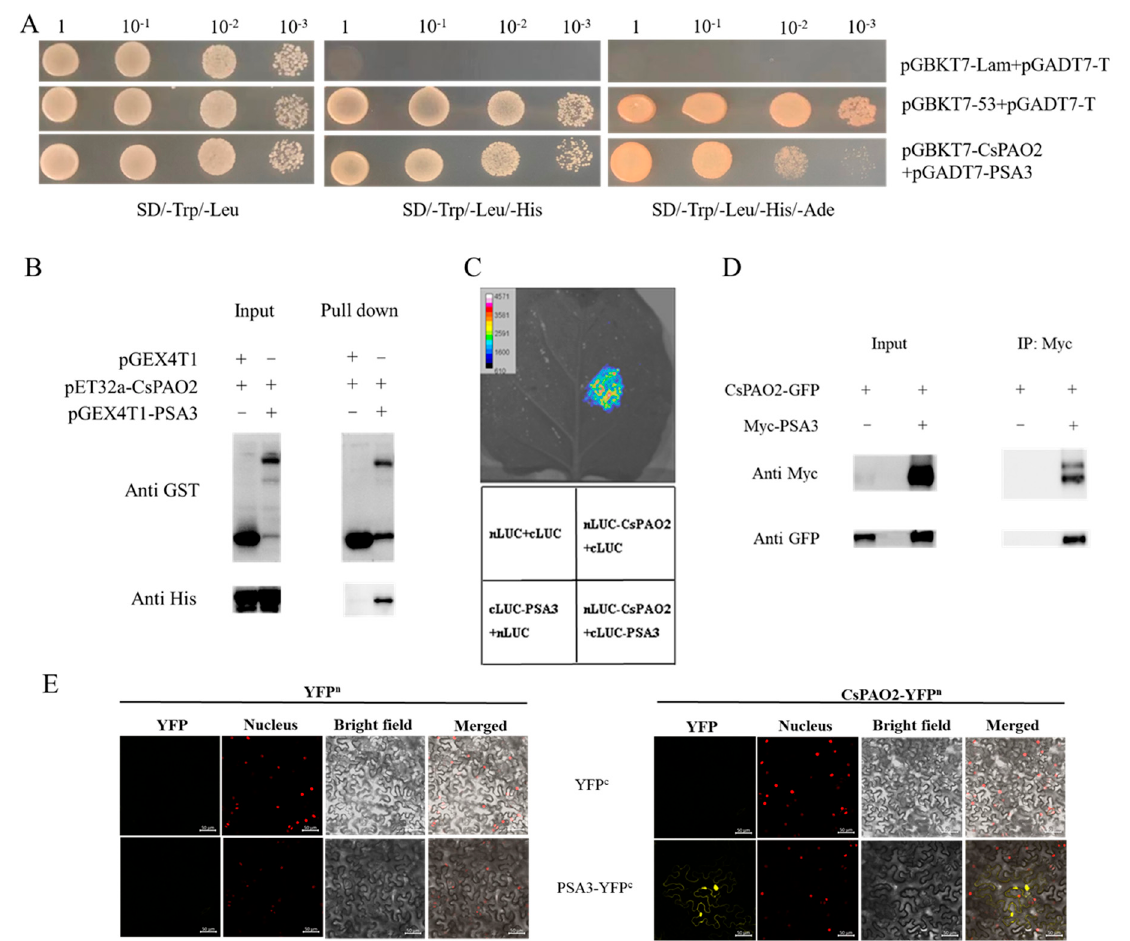
Figure 2. In vitro and in vivo validation of protein interaction between CsPAO2 and PSA3. ( A ) Yeast two-hybrid assay. CsPAO2 was ligated to DNA-binding domain (pGBKT7) as bait, while PSA3 was ligated to pGADT7. pGBKT7-Lam+pGADT7-T and pGBKT7-53+pGADT7-T was used as negative and positive control, respectively. ( B ) GST pull down assay. CsPAO2 and PSA3 was fused to pET32a and pGEX4T1, respectively. GST tag resin was used and proteins bound to the resin were detected by western blot with anti-GST and anti-His antibody. ( C ) LCA assay. CsPAO2 and PSA3 was ligated to nLUC and cLUC, respectively. Luciferase activity in tobacco leaf was determined at 48 h after agrobacteria infiltration. Empty vectors were transformed as control. ( D ) Co-IP assay. CsPAO2-GFP was expressed in tobacco leaves with or without Myc-PSA3, and Co-IP was performed by using Anti-c-Myc magnetic beads. Western blot was performed with anti-Myc and anti-GFP antibody. ( E ) BiFC assay. CsPAO2 was fused to N-terminal half of YFP (CsPAO2-YFP n ), and PSA3 was fused to C-terminal half of YFP (PSA3-YFP c ). Tobacco leaves co-transformed with empty YFP n or YFP c were used as control and observed using laser scanning confocal microscope. Scale bars (50 μ m) were added to the bottom right of each figure using ZEN 2 software. Red signals represented nucleus